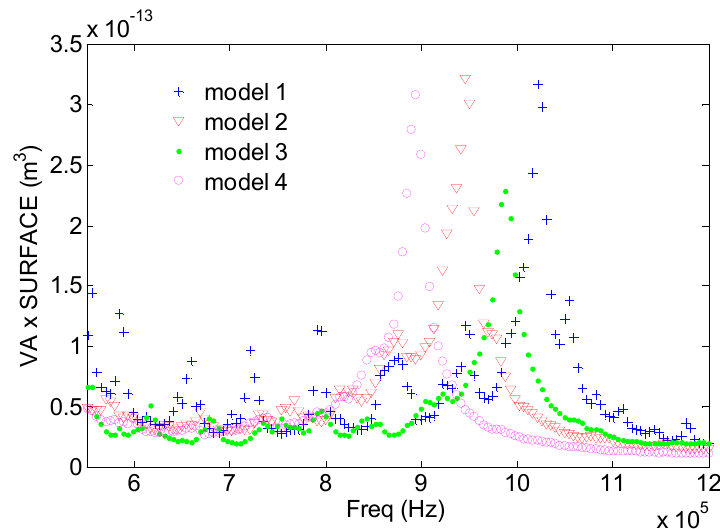
Figure 7. Average of the maximum value of the vibration along the z axis of all the calculated points in the aluminum face (VA × surface) as a function of the vibration frequency, multiplied by the real surface of each mode.